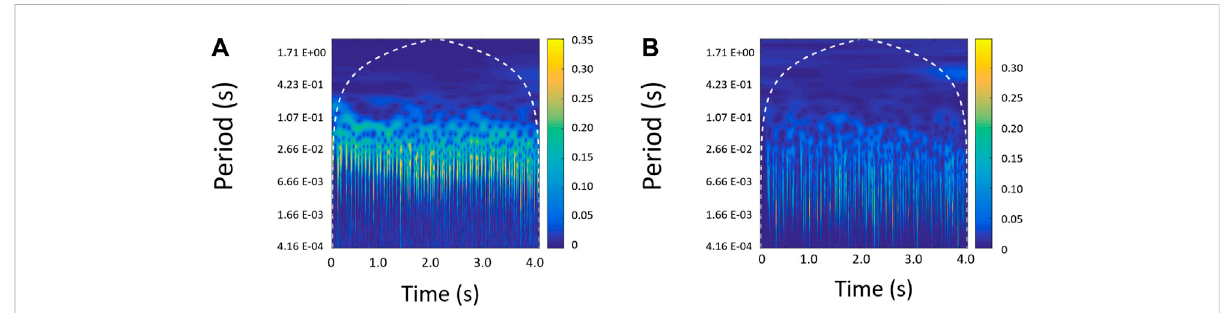
FIGURE 8 Representation of the absolute value of the complex wavelet transform coef fi cients for the signals identifying the occurrence of ELMs (A) and the arrival of the pellets into the plasma (B) . Each line in the images represents the evolution (a time-series) corresponding to a fi xed temporal scale. The period is plotted in logarithmic scale. The time series of the instantaneous phases and amplitudes are used for the CMI calculation.